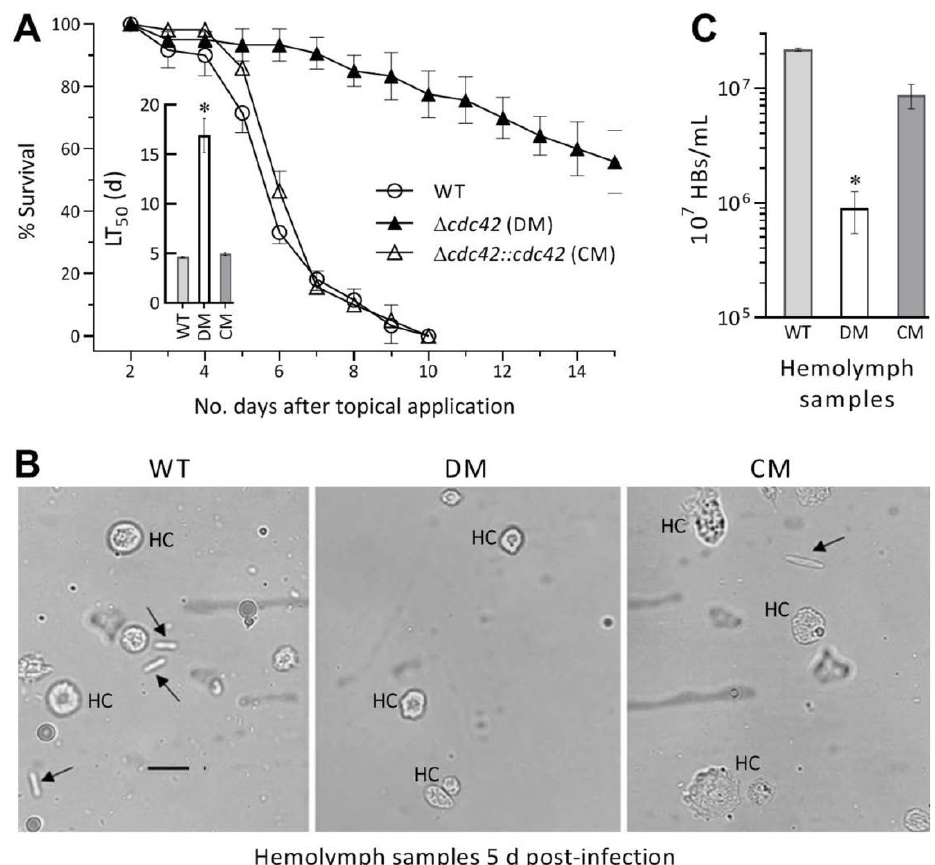
Figure 3. Essential role of cdc42 in insect-pathogenic lifestyle of B. bassiana . ( A ) Survival percentages of G. mellonella larvae after topical application (immersion) of a 10 7 conidia/mL suspension for normal cuticle infection and LT 50 (d) estimates made by modeling analysis of time-mortality trends. ( B ) Microscopic images (scale: 20 µ m) for the status of hyphal bodies (arrowed) and insect hemocytes (HC) in the hemolymph samples taken from surviving larvae 5 d post-infection. ( C ) Concentrations of hyphal bodies (HBs) from the hemolymph samples. * p < 0.05 in Tukey’s HSD tests. Error bars: SDs from three independent replicates ( A ) or three surviving larvae infected per strain ( C